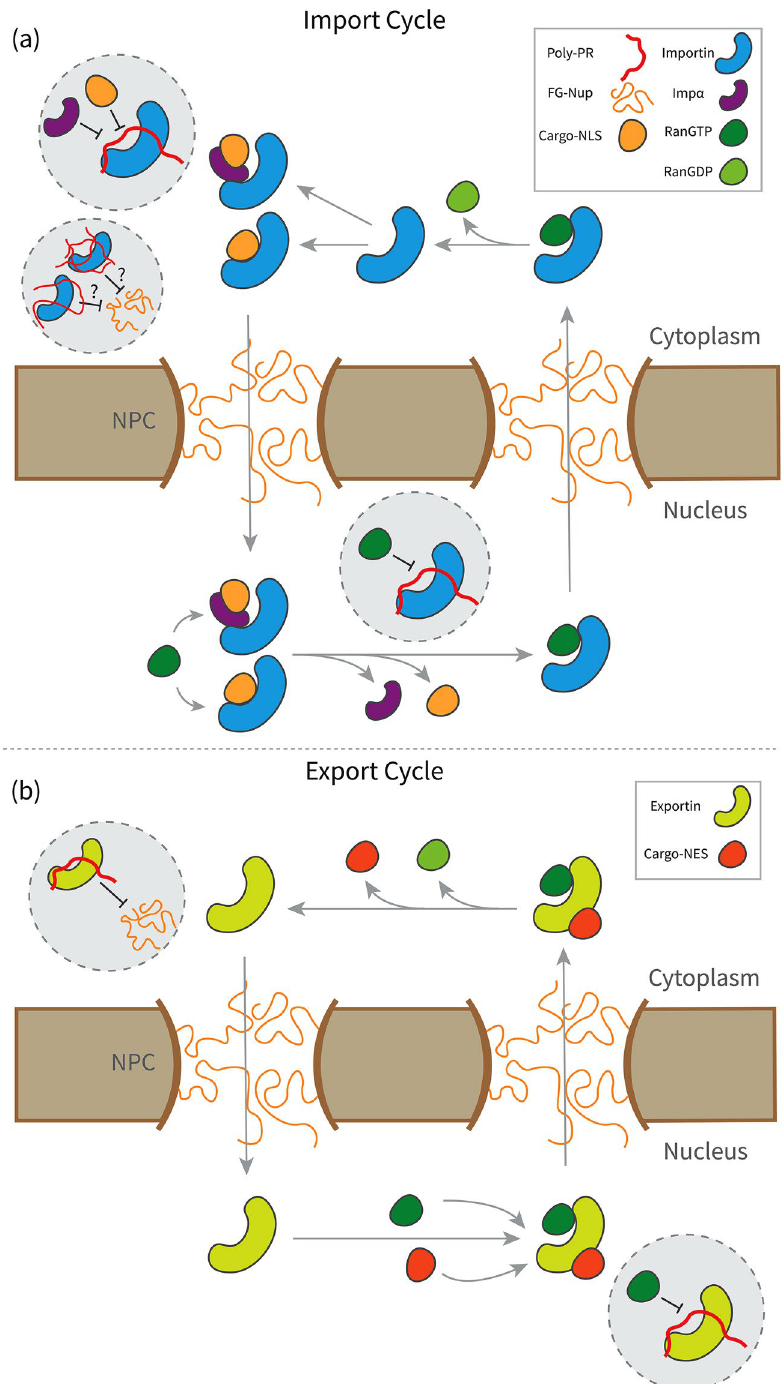
Figure 4. A mechanistic picture for the key molecular interactions that drive poly-PR interference with the function of Kapβs in the nucleocytoplasmic transport. ( a ) (Top panel) Proposed schematic for the mechanistic pathways of poly-PR interference with the import cycle. Poly-PR could cause defects in cargo loading in the cytoplasm and cargo-release in the nucleus by interaction with NLS-cargo, IBB domain, and RanGTP binding sites of importins. Increasing the length or concentration of poly-PR, increases the interaction of poly-PR with the outer surface of the importin, suggesting a possible change in the way the importin interacts with the FG-Nups. ( b ) (Bottom panel) Proposed schematic for the mechanistic pathways of poly-PR interference with the export cycle. Poly-PR could cause defects in cargo loading in the nucleus by interaction with the RanGTP binding sites. Poly-PR might also cause defects in the transport of exportin back into the nucleus by interaction with the FG-Nup binding